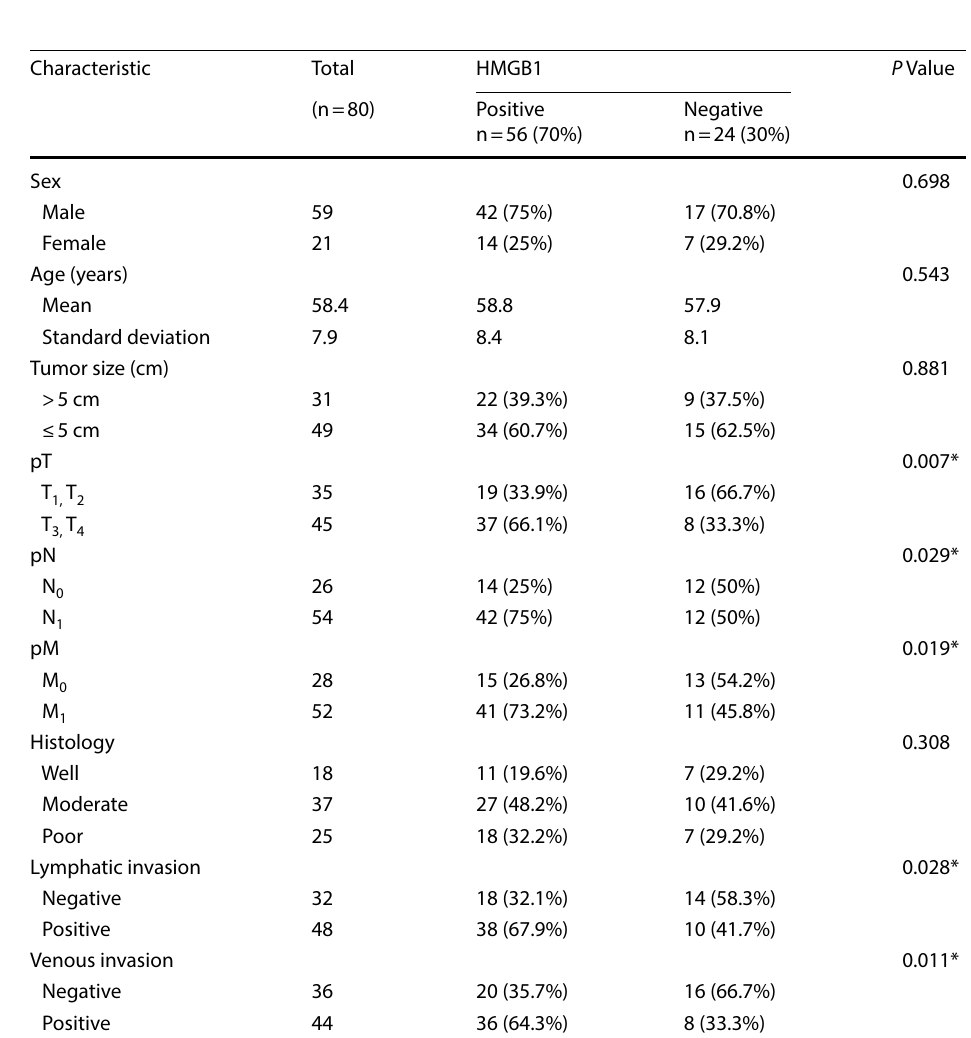
Fig. 3 The protein expression patterns of HMGB1 and RAGE in the tumor esophageal tissue (ESCC) and adjacent esophageal tissue. A 1, and 2: Banding pattern of HMGB1 and RAGE pertinent to the adjacent esophageal tissue group whereas 3 and 4: band- ing patterns of HMGB1 and RAGE across the esophageal tissue in ESCC group. B Densitometry quantifica- tion of HMGB1 and RAGE expression in two groups. The HMGB1 and RAGE protein expression were significantly increased in the ESCC group than the control group. Data were presented as mean ± SD, **P < 0.01